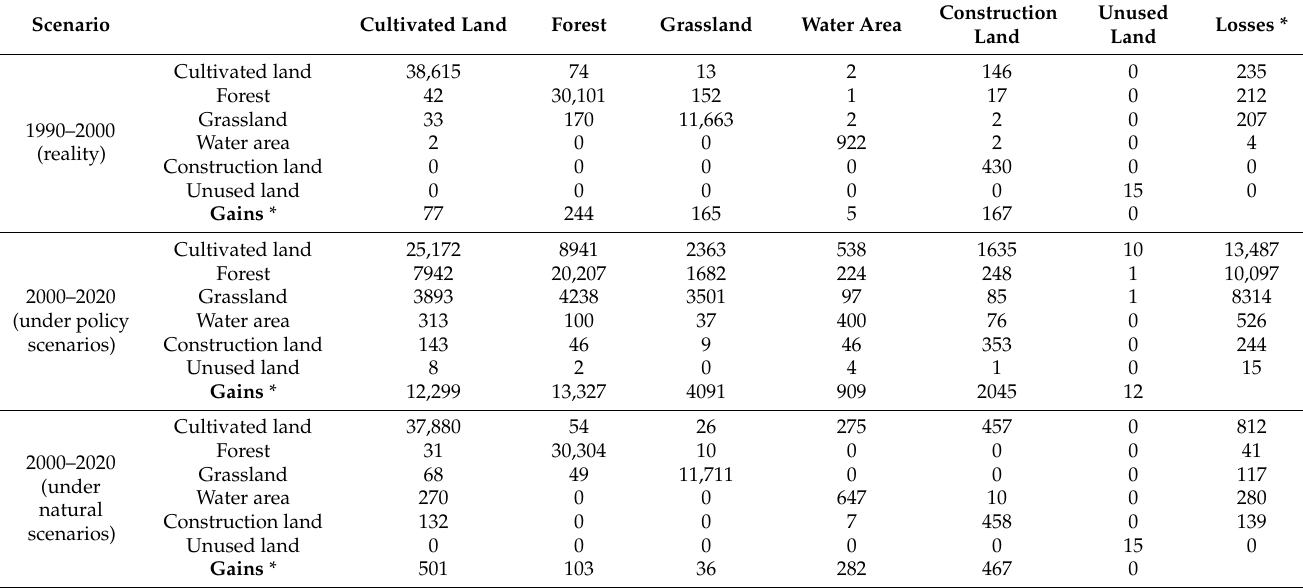
Table 4. 1990–2020 Land Use Transfer Matrix (unit: km 2 ).